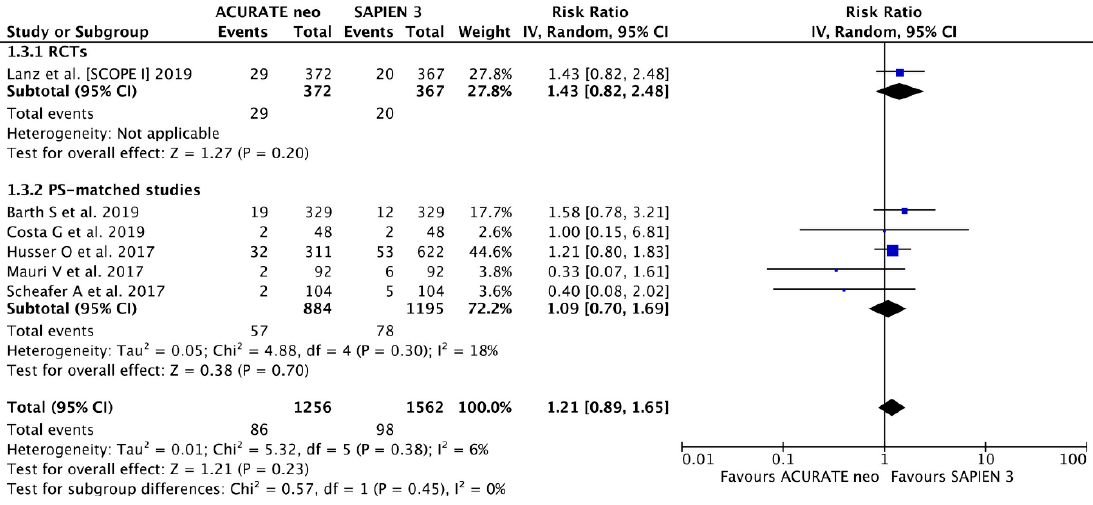
Figure A5. Clinical outcomes. Individual and summary risk ratios with corresponding 95% confidence intervals for the comparison of ACURATE neo and SAPIEN 3 in the analysis of major vascular complications.